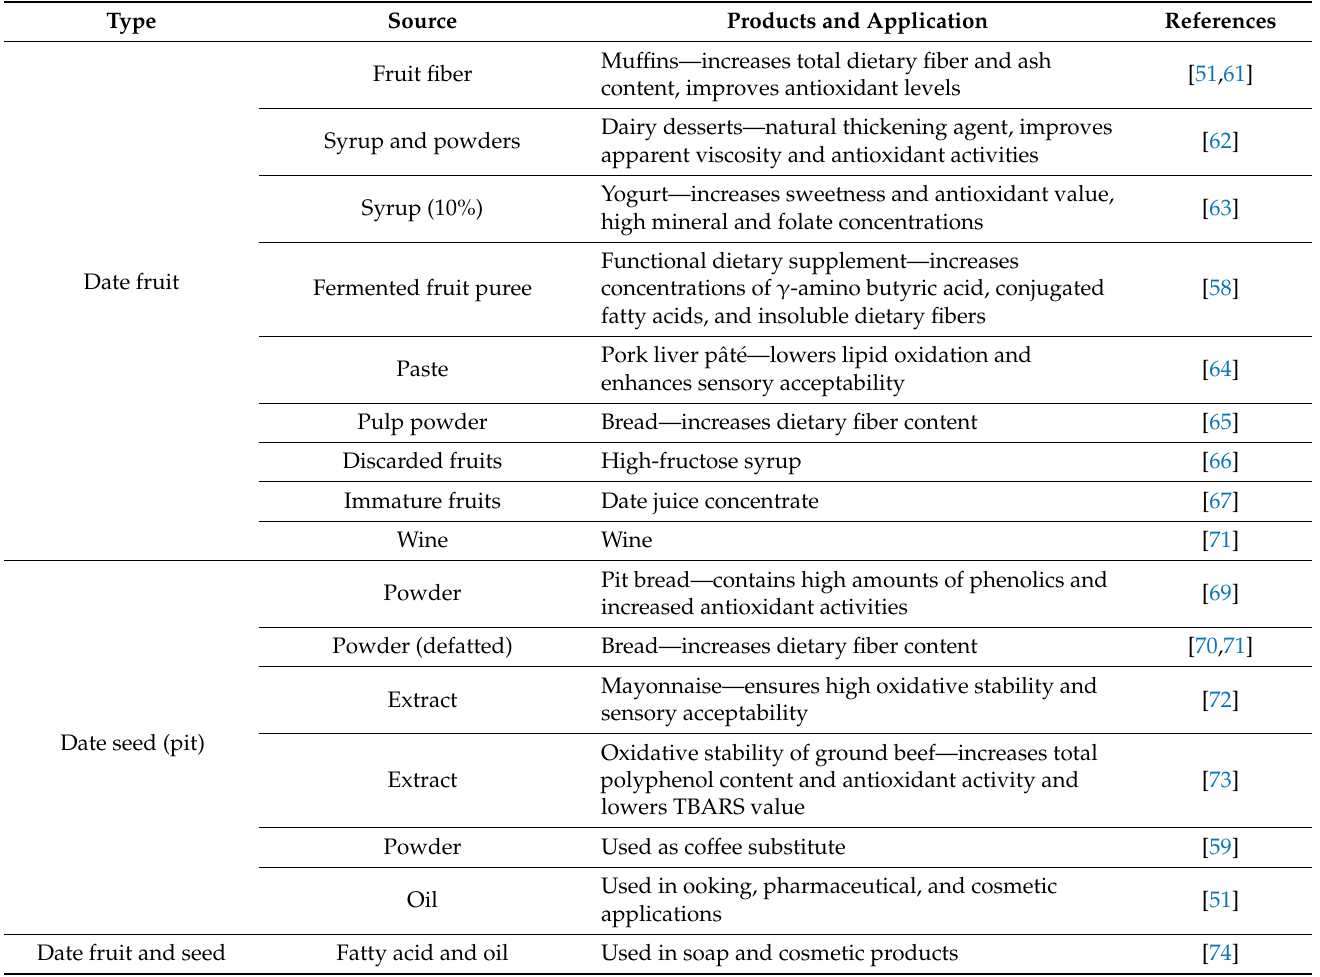
Table 3. Value-added food and cosmetic products from date fruits and